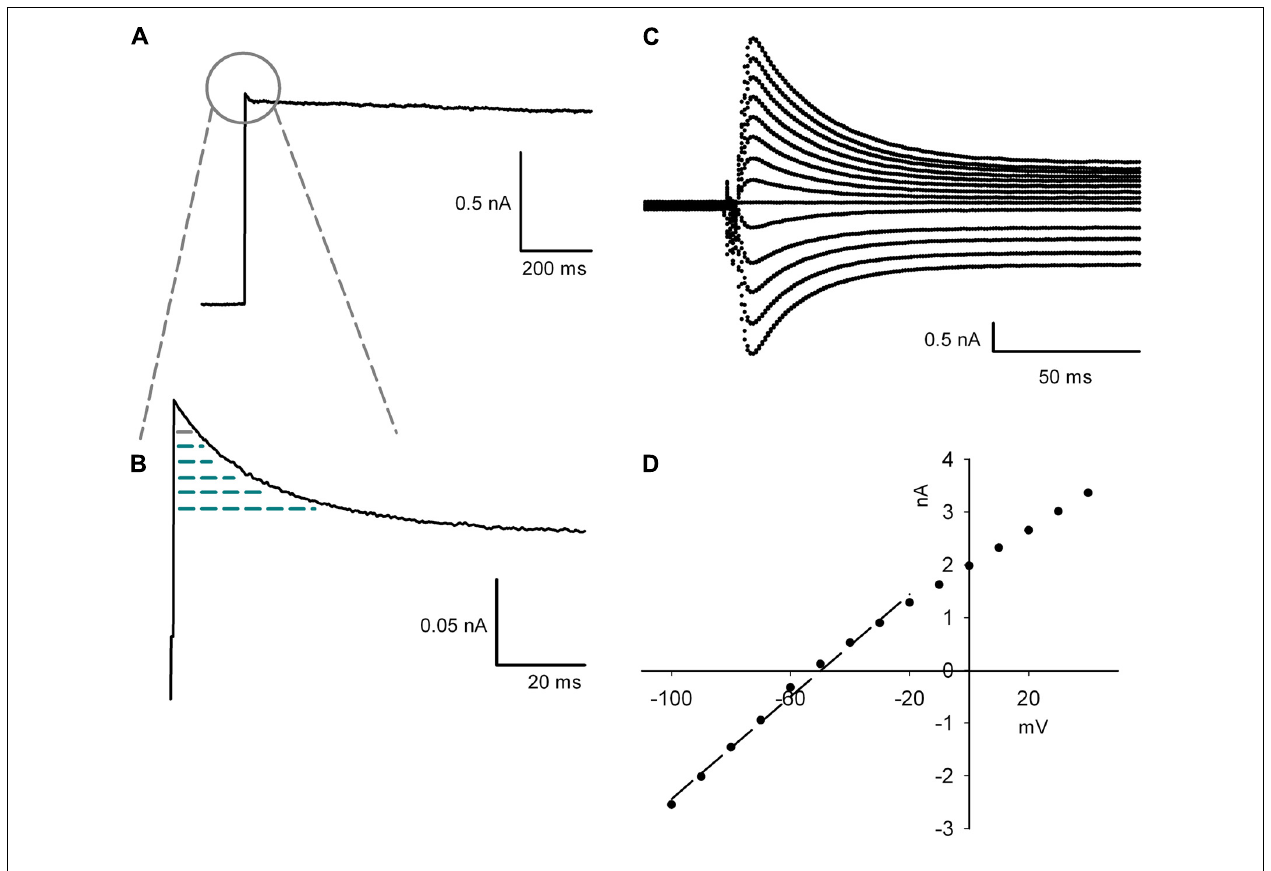
FIGURE 1 | Protocol for measuring the capacitance. (A) The capacitance of the voltage clamped area is derived form the partial integration of the capacitive transient during a step from − 50 to − 20 mV with 3 mM ofTEA blocking inactivating Kv3.3 currents. (B) Enlargement of the capacitive transient which is integrated from the start of the depolarization to the time point when theTEA sensitive inactivating current reaches its peak amplitude.